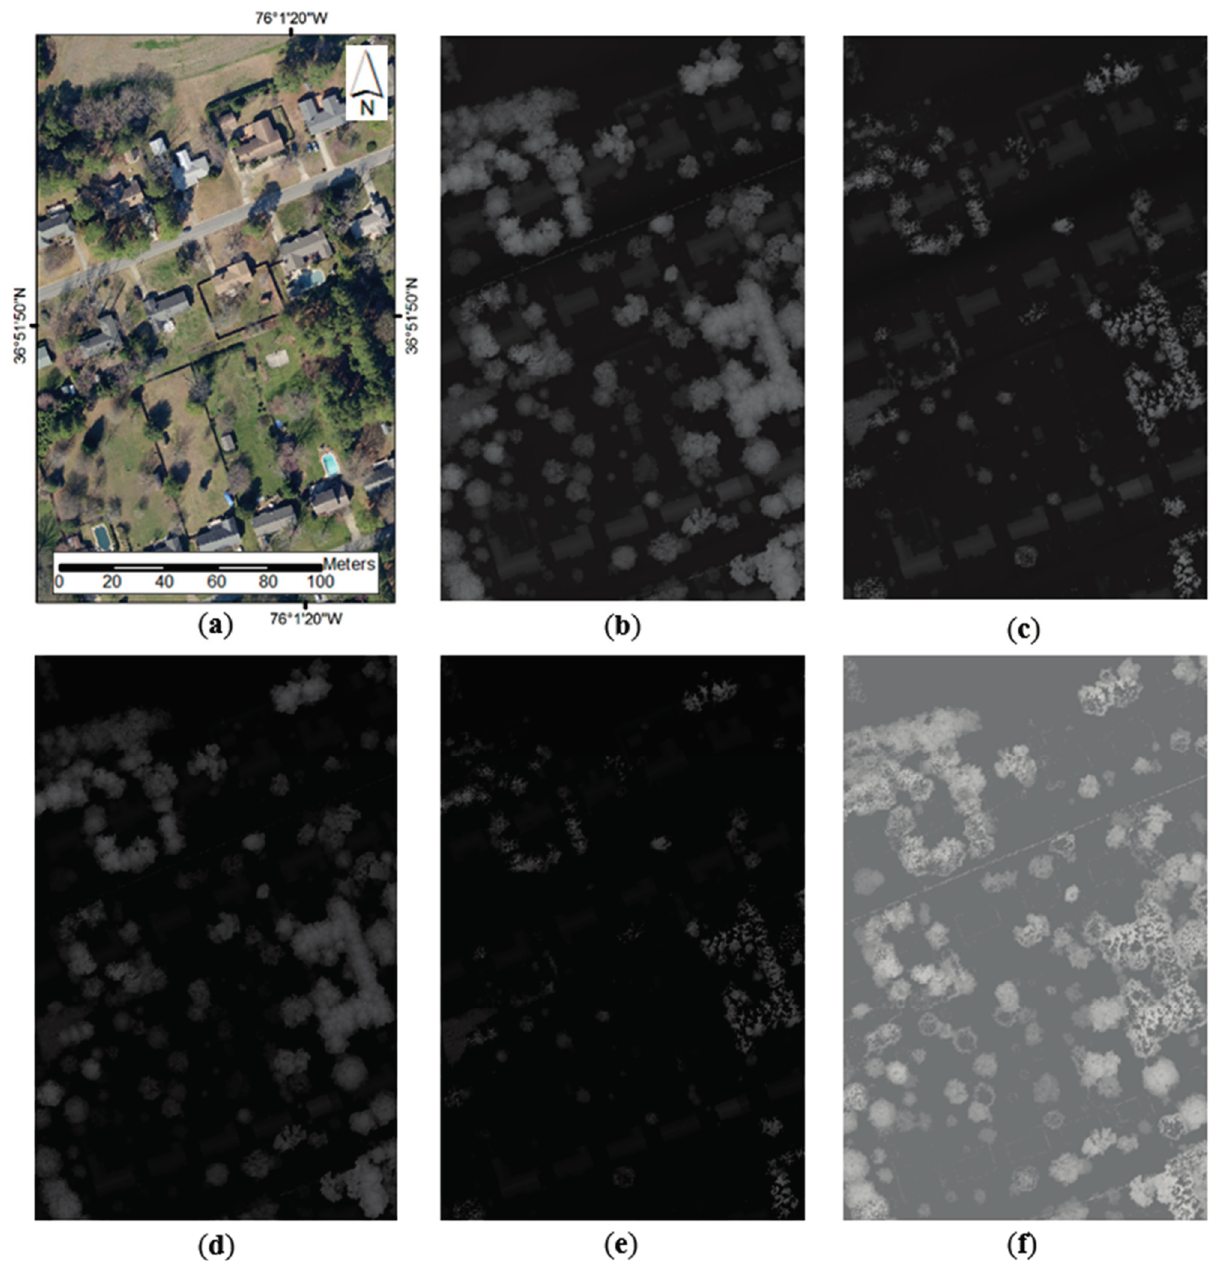
Figure 1. Common source datasets for GEOBIA-based tree-canopy mapping. ( a ) A 0.152-m GSD true-color orthoimage for Virginia Beach, Virginia, USA. ( b ) A LiDAR-derived 0.457-m GSD digital surface model (DSM). ( c ) Digital terrain model (DTM). ( d ) Normalized digital surface model (nDSM). ( e ) Normalized digital terrain model (nDTM). ( f ) Difference between nDSM and nDTM. Trees are shown as high positive values (white); other aboveground features (e.g., buildings) have values equal to or near zero